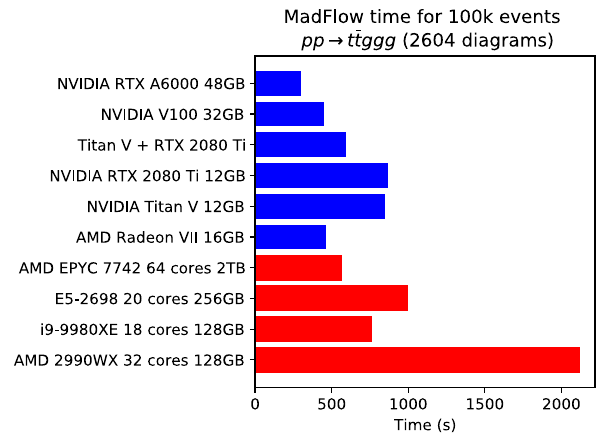
Fig. 4 Same as Fig. 3 for pp → t ¯ tggg at Leading Order. We confirm that a large number of diagrams can be deployed on GPU and obtain relevant performance improvements when compared to CPU results